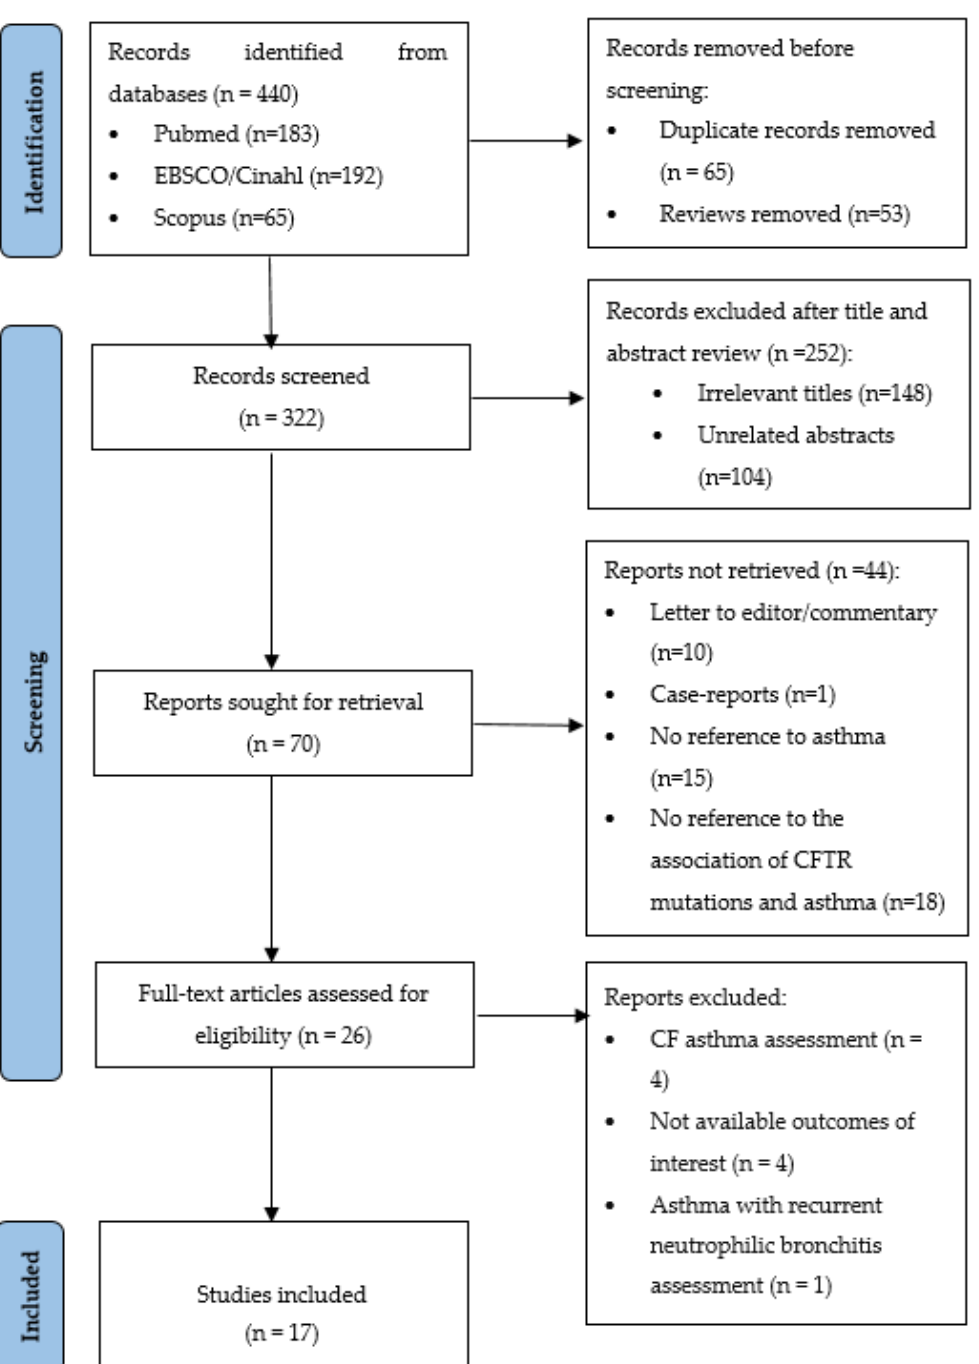
Figure 1. PRISMA diagram for study selection process.